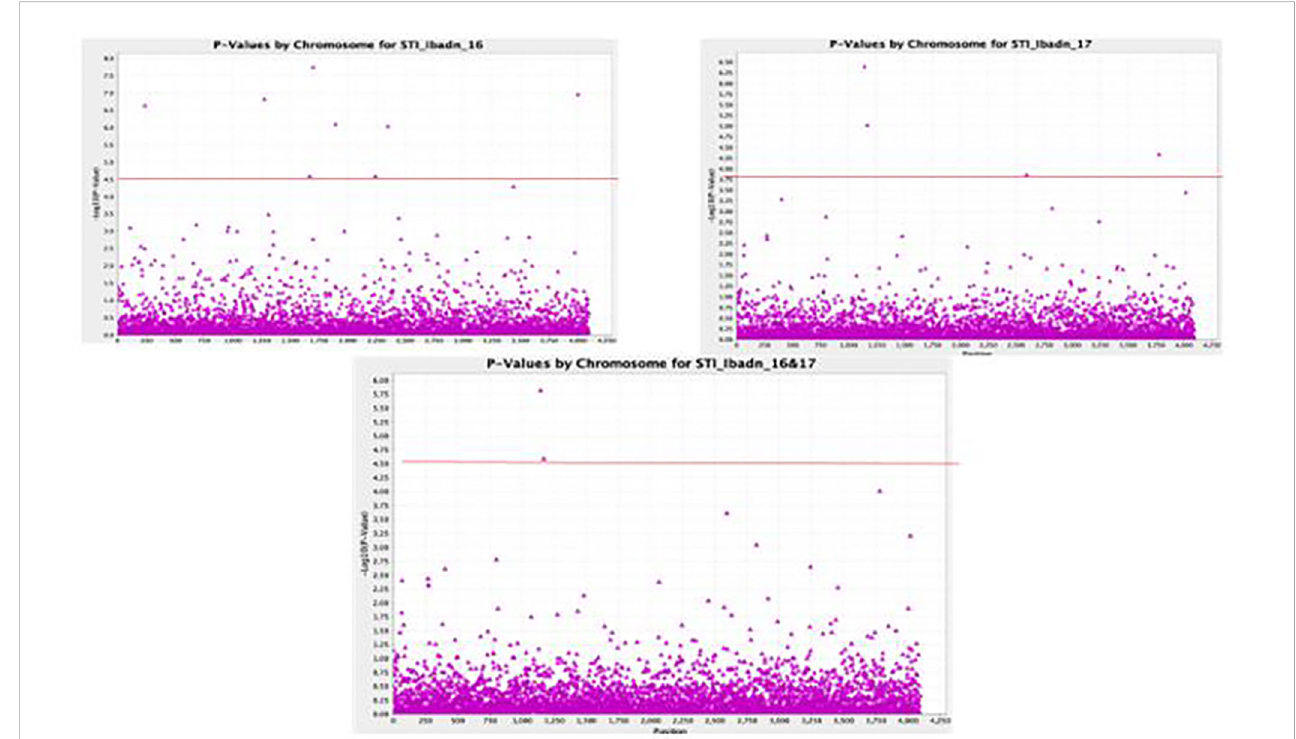
FIGURE 6 GWAS Manhattan Plot identifying the QTLs for Stress Tolerance Indices in Kano for two